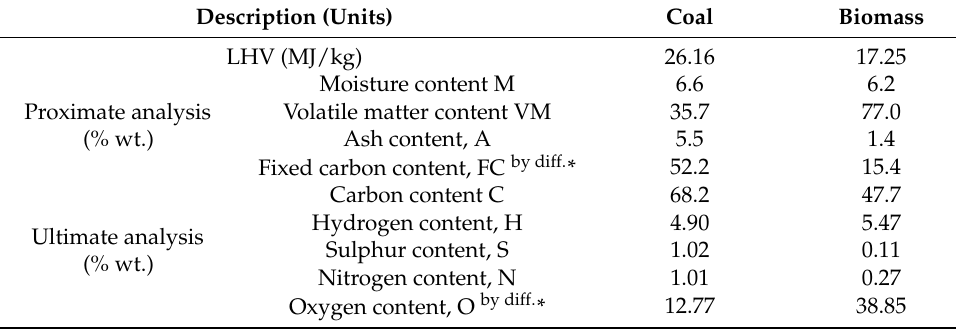
Table 1. Properties of fuels (as received).